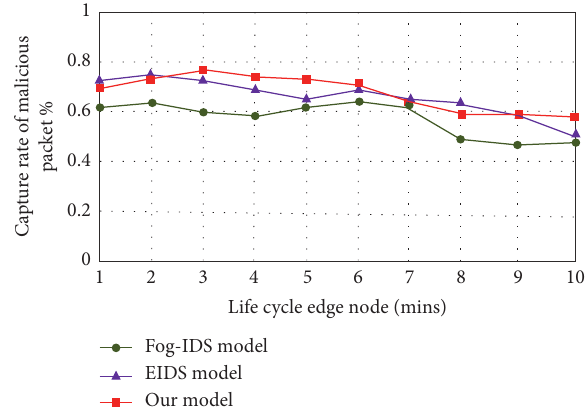
Figure 11: Malicious packet capture rate under ( τ , υ ) � ( 0 . 5 , 0 . 3 )